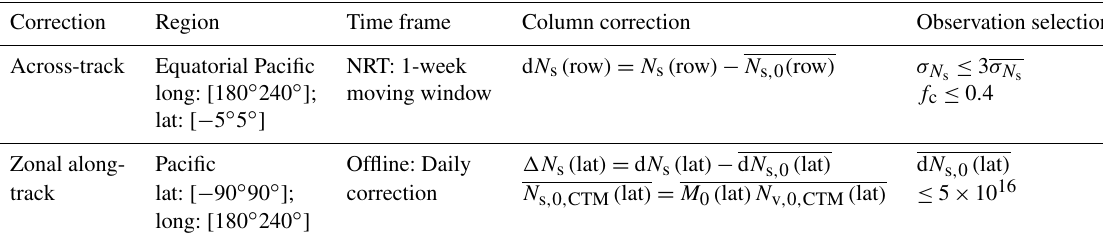
Table 6. Two-step normalization of the HCHO vertical